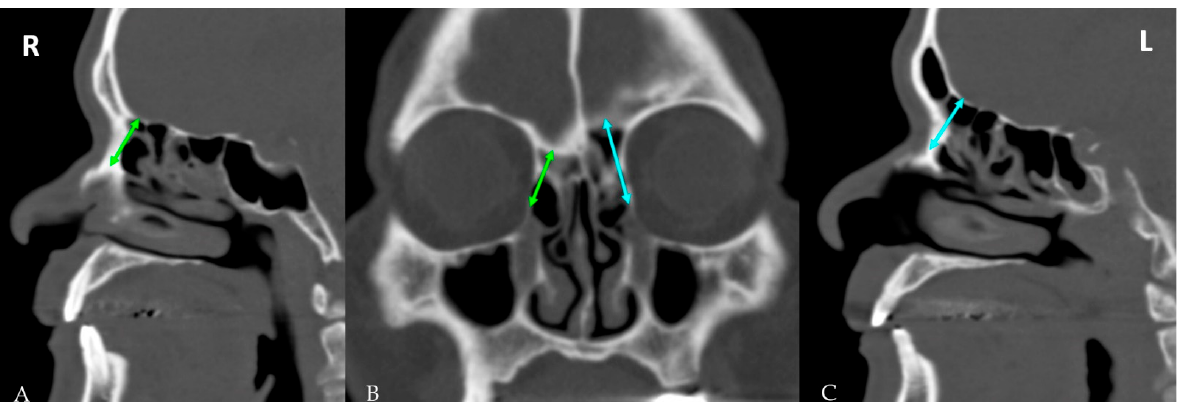
Figure 2. The definition of the frontal sinus roof ‒ supraorbital margin (F-O), frontal sinus roof ‒ na- sion (F-N), and inter-orbital distance.